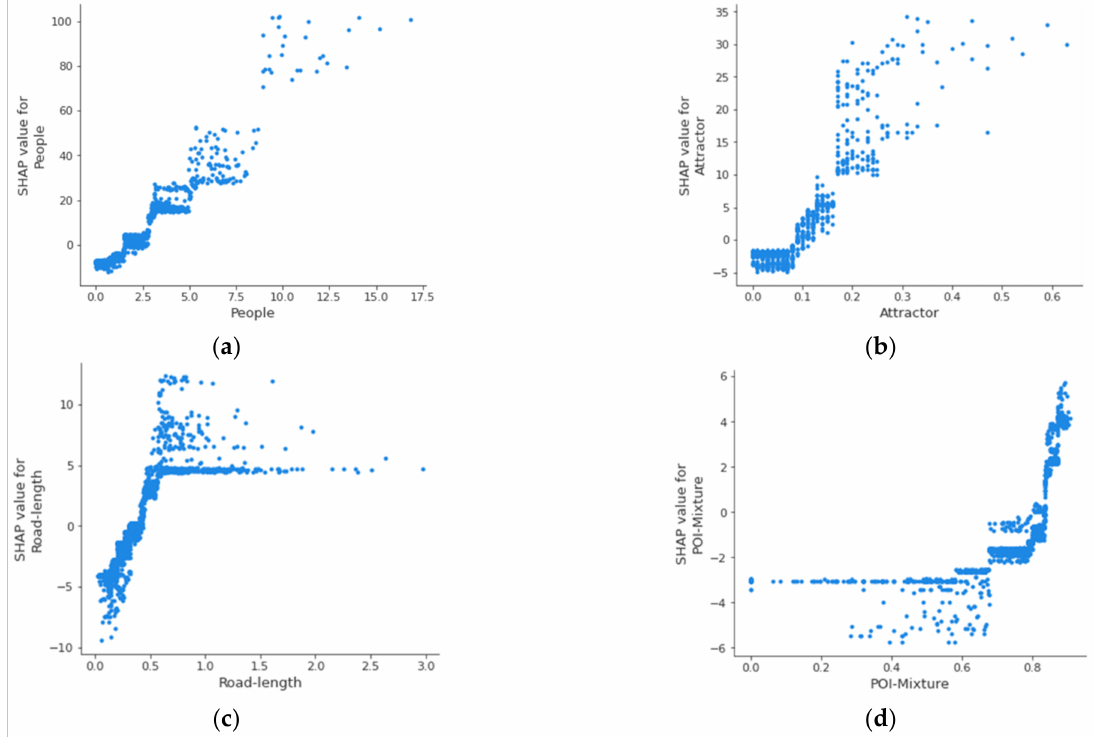
Figure 9. The nonlinear effect of explanatory variables on street property crime. ( a ) the number of people on the street, ( b ) the number of crime attractors, ( c ) the length of the street segment, ( d ) the mixture of